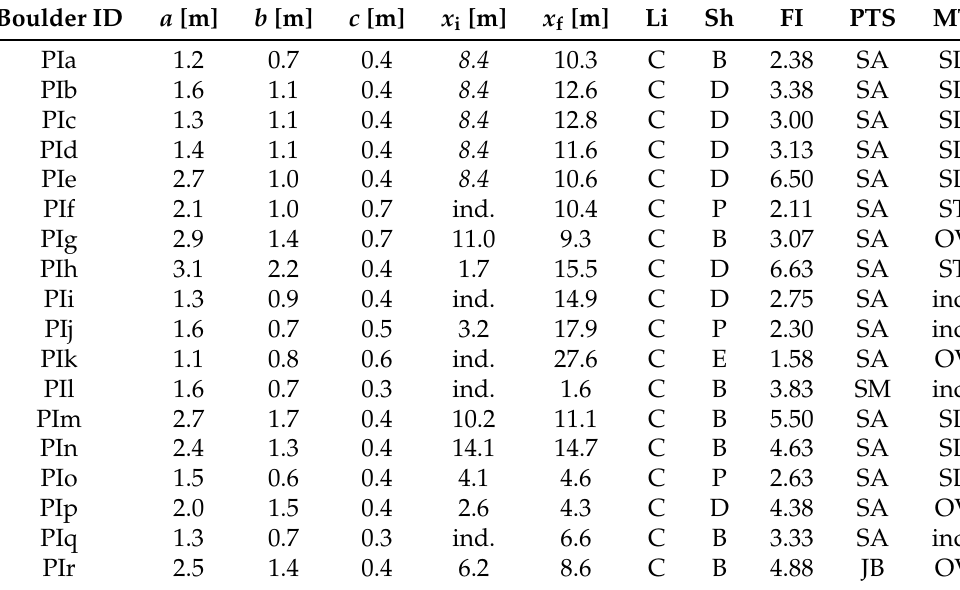
Table A6. Main features of the displaced boulders at the Punta Pizzo headland; see the caption of Table A2 for symbols.